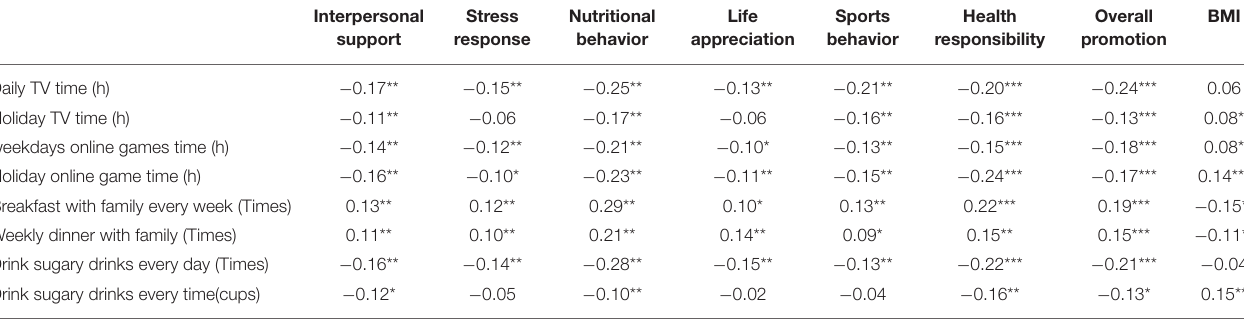
TABLE 3 | Statistical table of correlation matrix between daily living habits, leisure time arrangement, and health promotion behavior of adolescents.